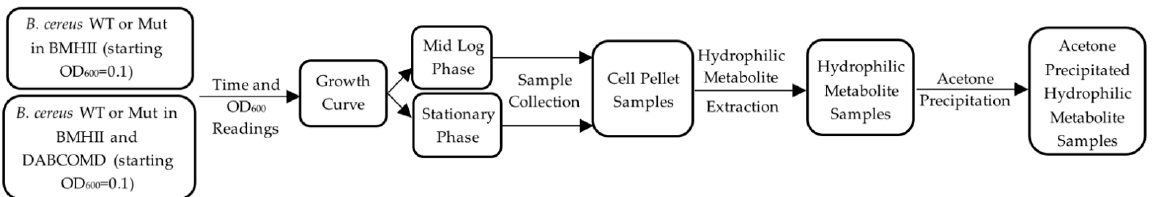
Figure 8. Overview of the protocol from the start of the cultures to the hydrophilic metabolite samples ready to be pelleted, frozen at − 80 °C, and put in NMR buffer. The processes for unchallenged and challenged samples are the same except for the inclusion of DABCOMD in the challenged sample media.